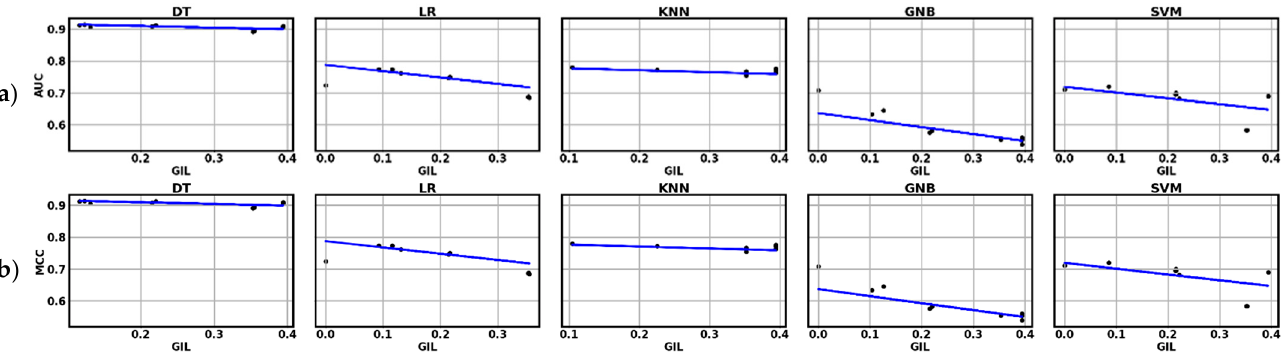
Figure 3. The linear regression model representing the relationship between the performance metrics area under curve ( AUC ), Matthews correlation coefficient ( MCC ) and the generalized information loss ( GIL ) metric for all tested machine learning models. ( a ) AUC as a function of GIL . ( b ) MCC as a function of GIL .